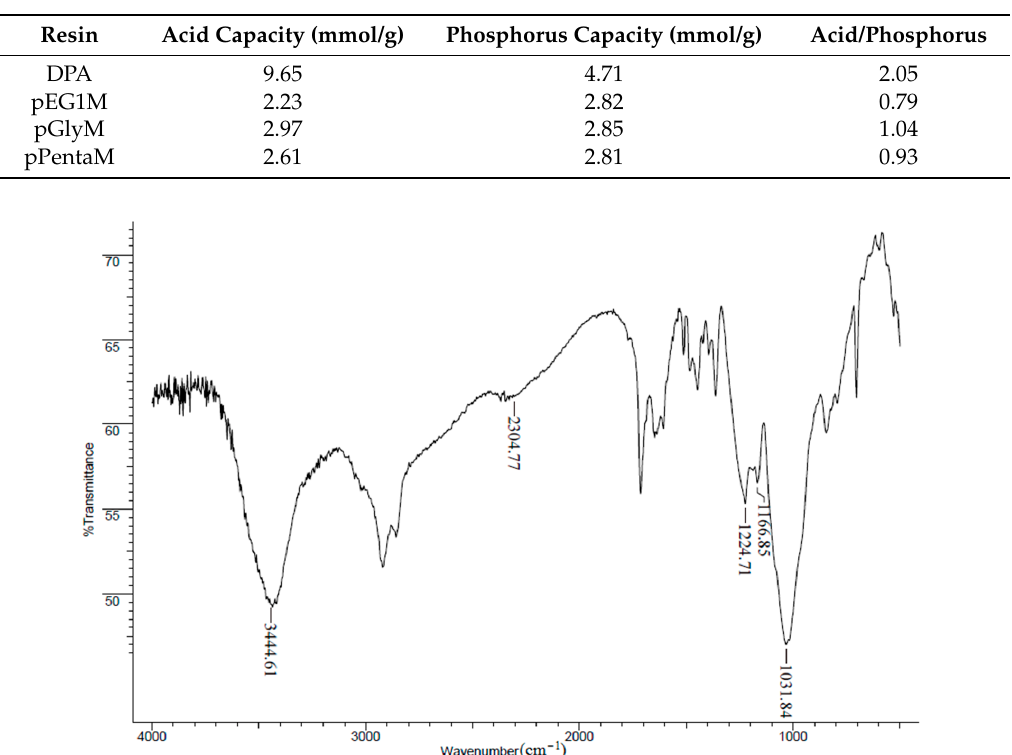
Figure 2. FTIR spectrum of pPentaM.